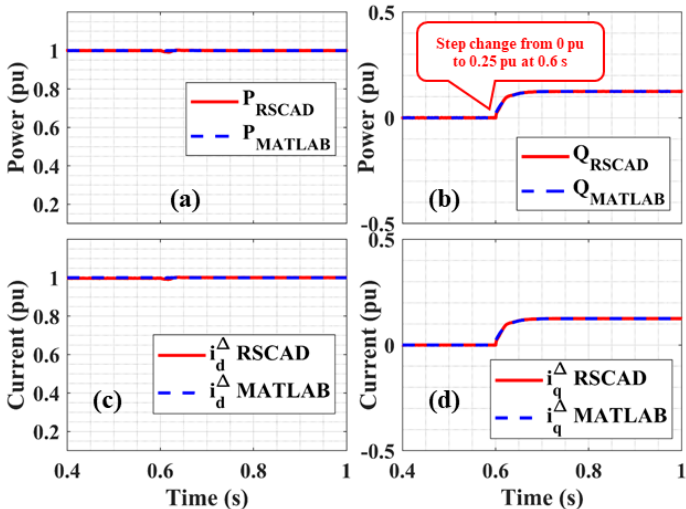
current; and ( d ) i ∆ q current; in d